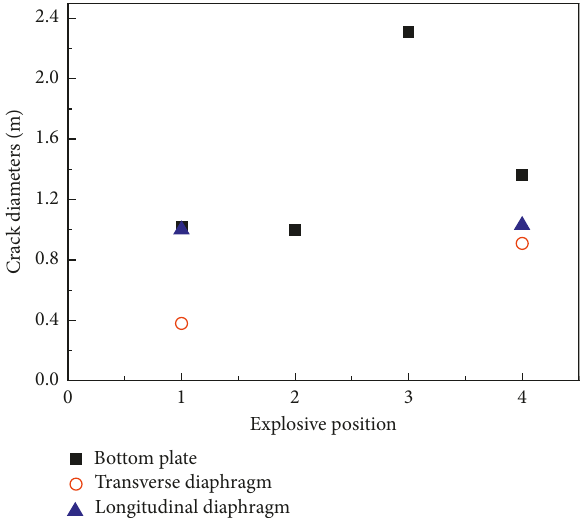
Figure 17: Crevasse diameter of plates in different explosive positions.